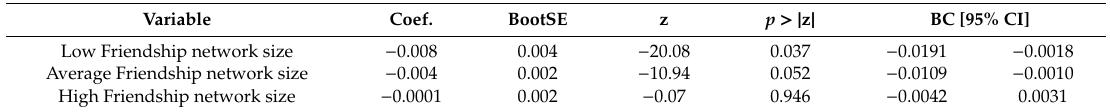
Table 5. The conditional indirect e ff